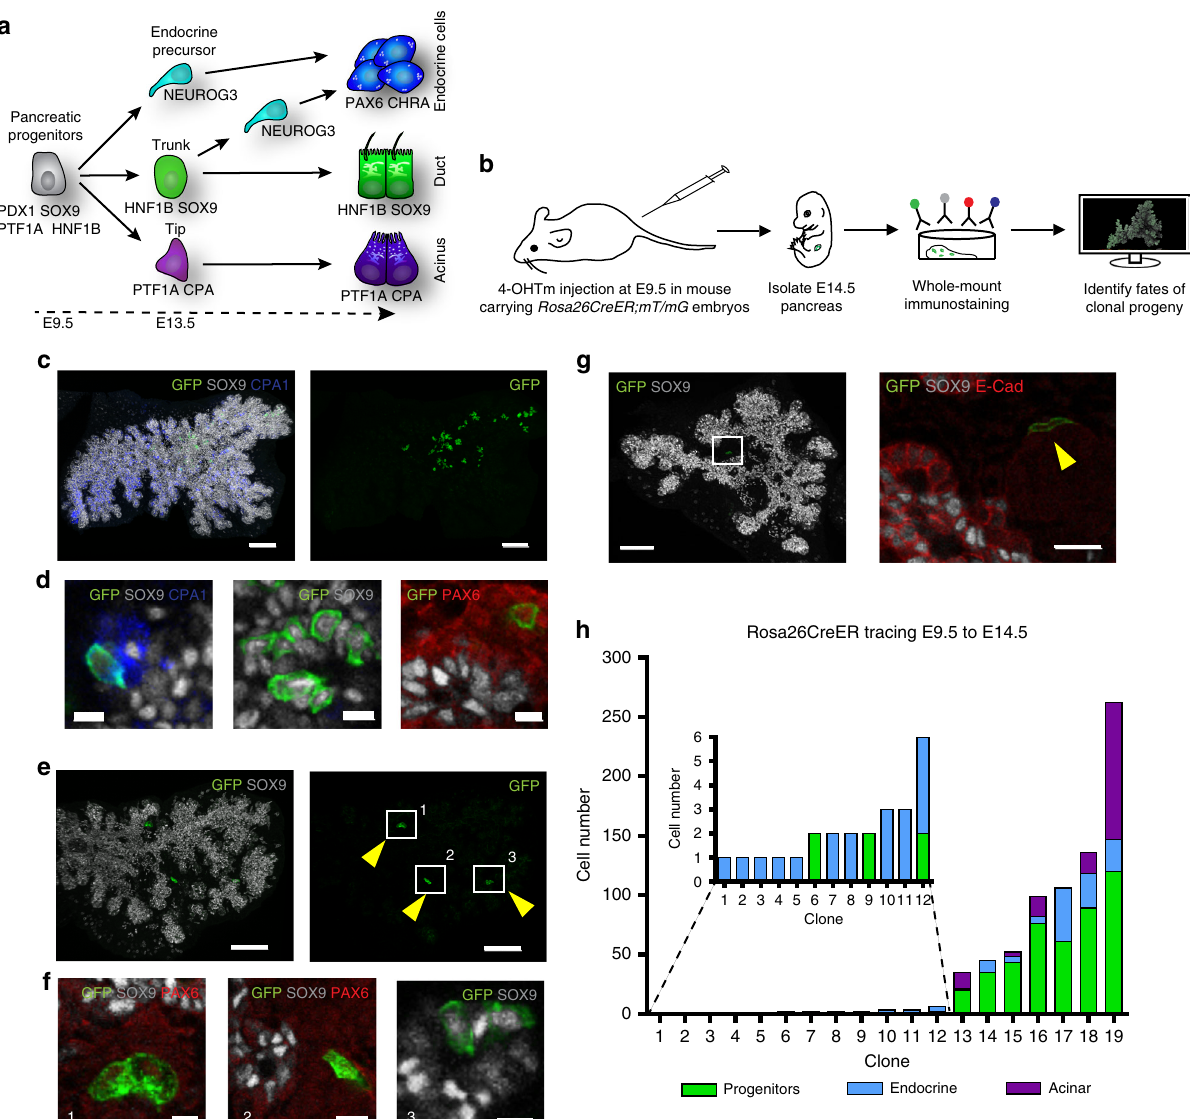
Fig. 1 Rosa26 CreER -mediated clonal analysis reveals heterogeneous contribution of E9.5 progenitors to pancreas organogenesis. a Schematic overview of lineage relationships based on previous global lineage tracing. b Schematic overview of strategy applied to identify fates of clonal progeny from E9.5 pancreatic progenitors. c 3D maximum intensity projection (MIP) of a large, multipotent clone containing acinar (CPA1), progenitors lining the ducts (SOX9) and endocrine progeny (PAX6, from other multipotent clone) d . Scale bars, 100 µ m c and 15 µ m d . e 3D MIP of a bipotent clone containing endocrine (insets 1 and 2) and ductal (inset 3) clonal progeny f . Scale bars, 100 µ m e and 10 µ m f . g 3D MIP and optical section (inset) showing a single-labelled endocrine cell after clonal analysis from E9.5 to E14.5. Note the localisation of the GFP + cell in an E-CAD Low endocrine cluster. Scale bars, 80 µ m and 15 µ m (inset). h Quanti fi cation of clone sizes and compositions following clonal analysis from E9.5 to E14.5 ( n = 170 embryos, 20 with clones, 1 excluded due to poor immunocytochemistry-the images displayed show representative data from